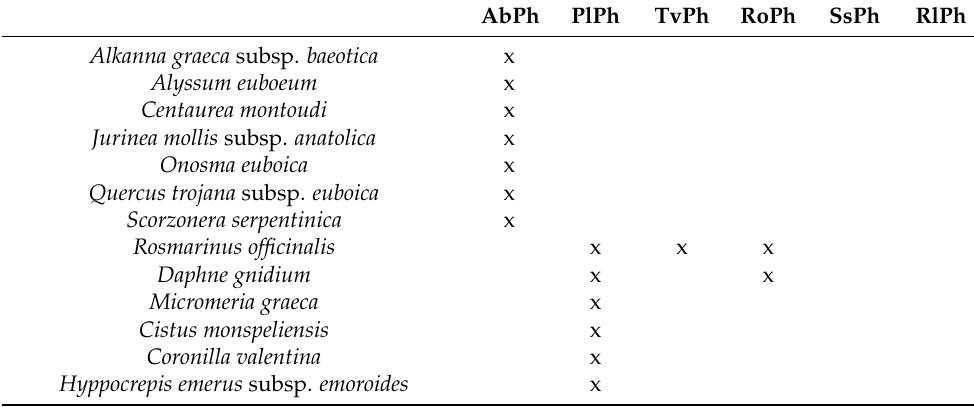
Table 3. Diagnostic species that separate this alliance from the other five alliances in the order. AbPh: Alkanno boeticae-Pinion halepensis Mucina & Dimopoulos 2009; PlPh: Pistacio lentisci-Pinion halepensis Biondi, Blasi, Galdenzi, Pesaresi & Vagge in Biondi, Allegrezza, Cassavecchia, Galdenzi,